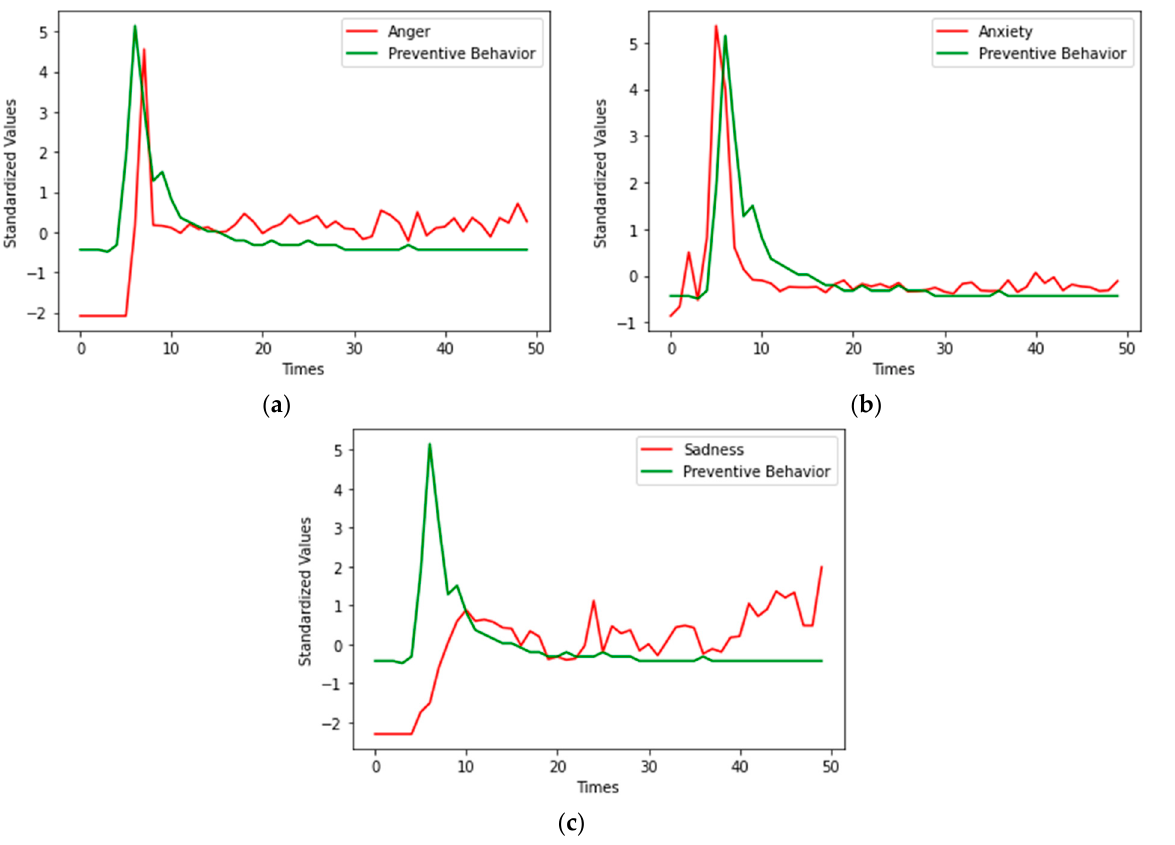
Figure 2. Overall emotions and preventive behaviors for 50 waves. ( a ) Anger and preventive behaviors; ( b ) Anxiety and preventive behaviors; ( c ) Sadness and preventive behaviors.